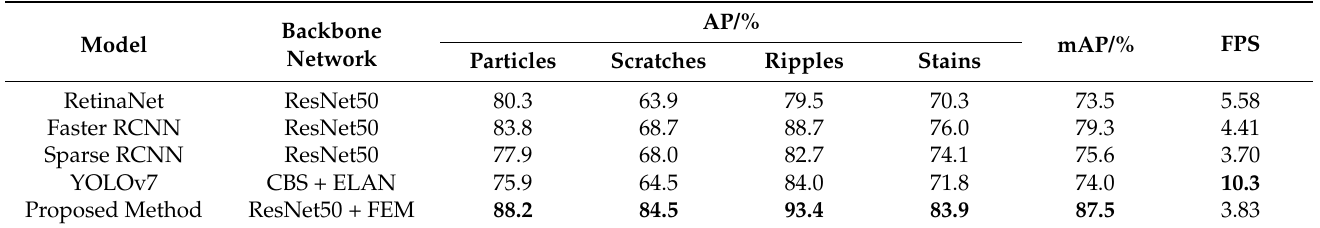
Table 1. Comparison of the test results of different